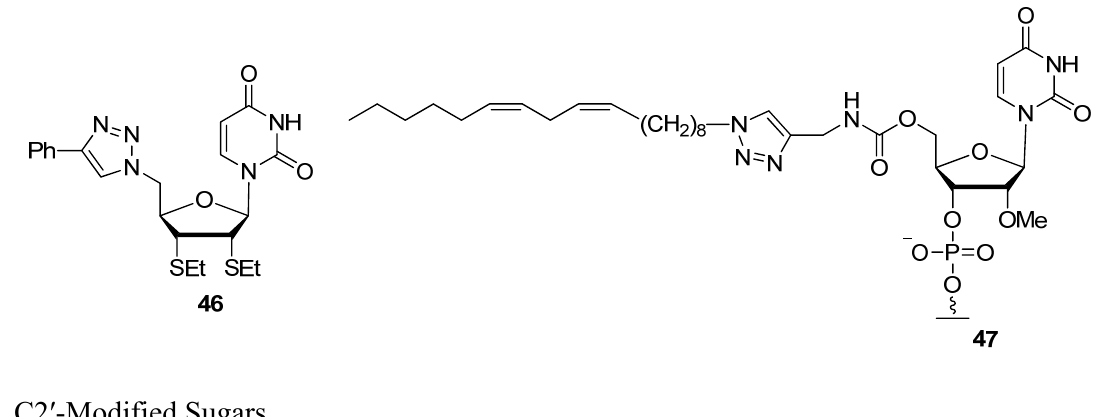
Figure 7. Uridine nucleoside analogues C5 ′ -triazole modified